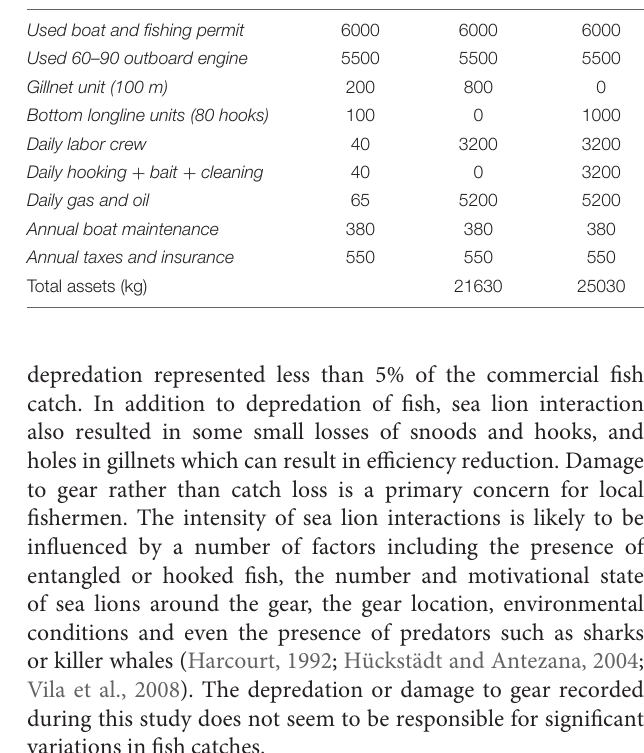
and marine mammals (Szteren and Páez, 2002; Donoghue et al., 2003; Hamer et al., 2012). However, no seabirds were caught